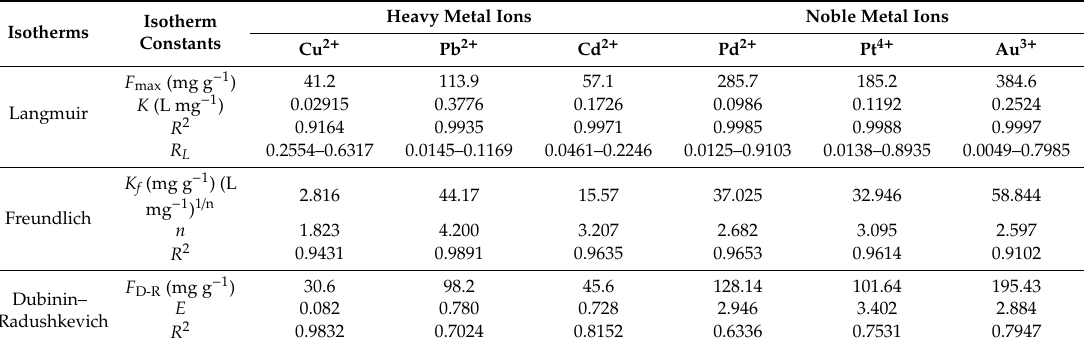
Table 1. Parameters of the Langmuir, Freundlich, and Dubinin–Radushkevich isotherms for the adsorption of HM and NM ions onto DTC-g-PE-DA@GB@PU and PE-DA@GB@PU, respectively, at 25 °C.